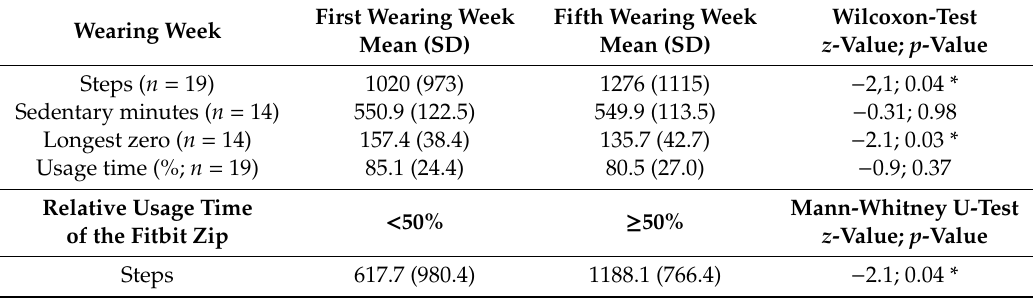
Table 3. Steps per day and wearing time (usage time (%)) separated by wearing week (first vs. fifth wearing week) and usage behavior ( < 50% vs. ≥ 50%